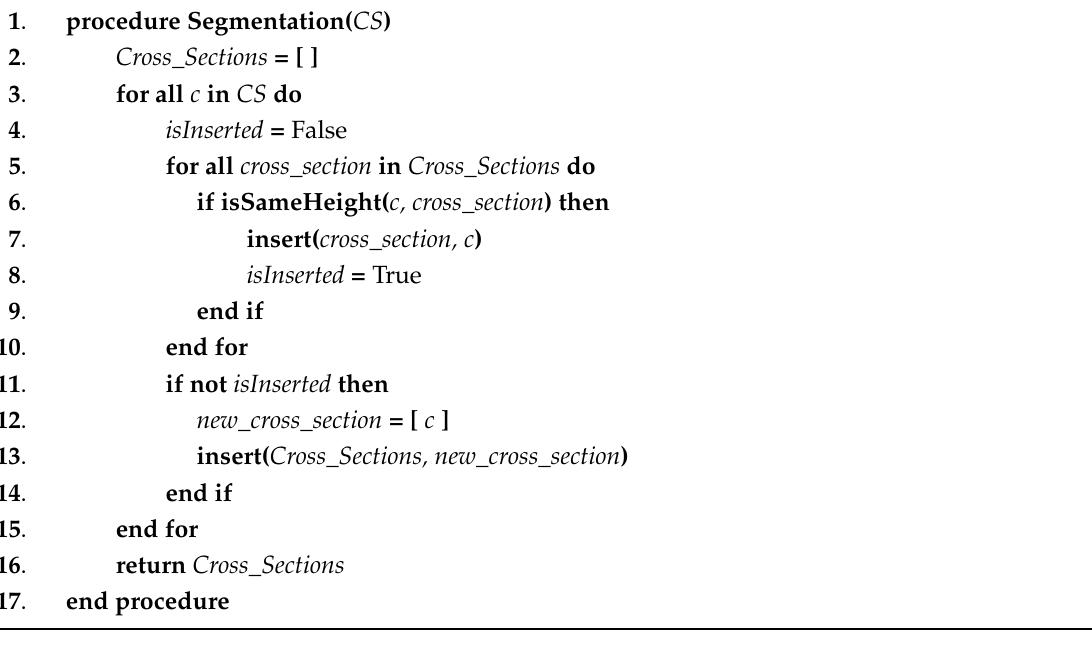
Algorithm 1 ： Building Segmentation. CLOD generation workflow Algorithm 1: Building Segmentation. CLOD generation workflow